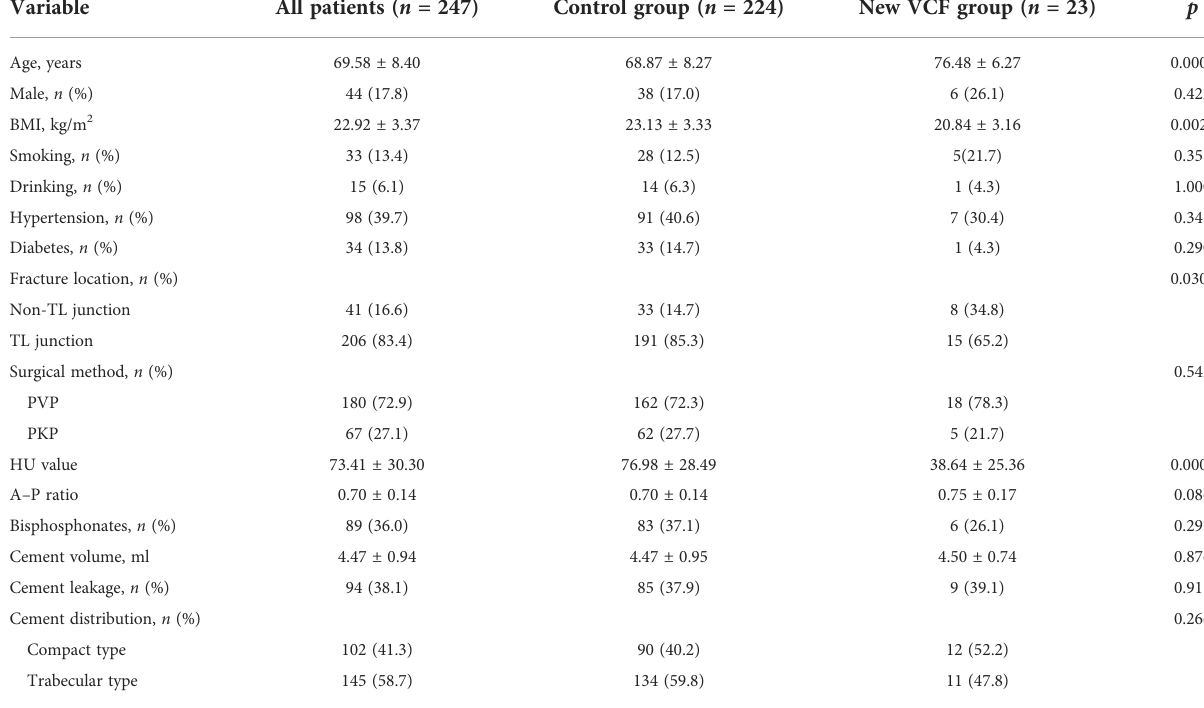
TABLE 1 Information of the study subjects and results of univariable analysis of the control and new VCF groups.